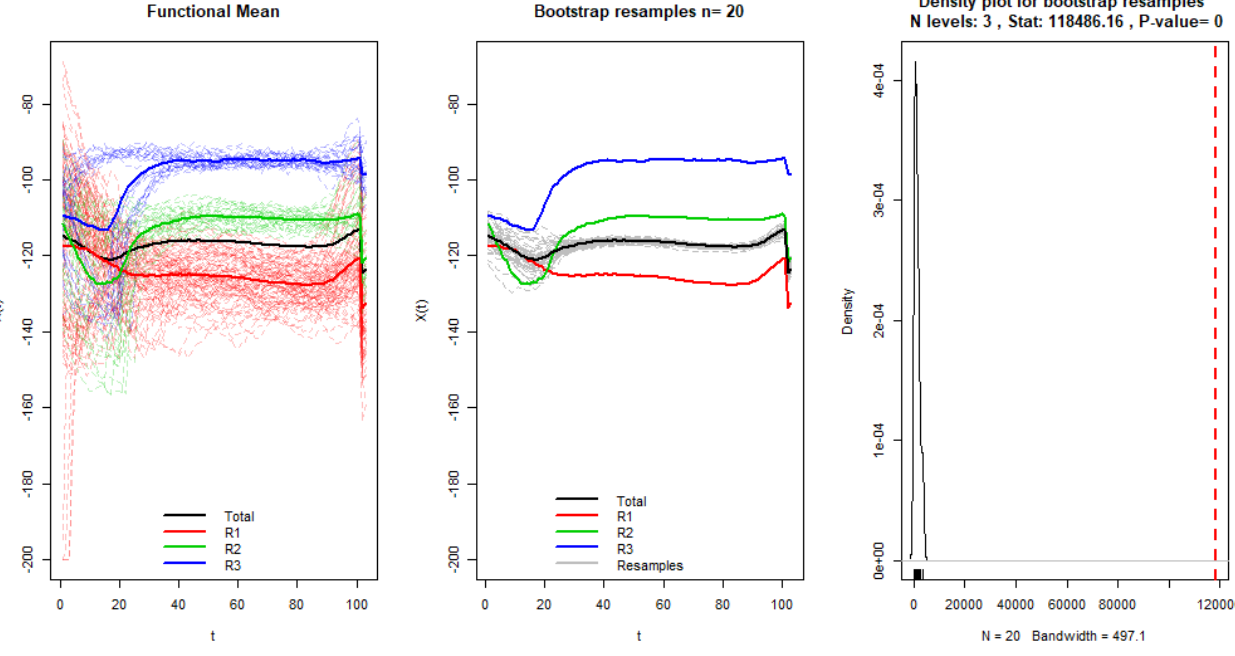
Figure 9. Functional ANOVA results of the analysis of the upper harmonic (USH) trajectories with the motor under both load